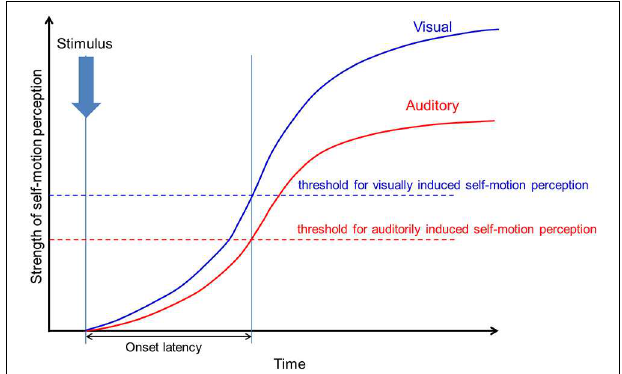
FIGURE 13 | The thresholds of visually and auditorily induced self-motion perception. The blue line shows the strength threshold of visually induced self-motion perception. The red line shows the strength threshold of auditorily induced self-motion